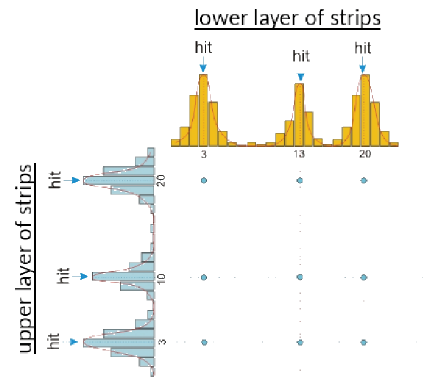
spatial coordinates represented by intersections of fired strips. Search for a cluster and its parameterization are done separately in each layer. Generally speaking, a layer with a given set of fired strips is considered as a one-dimensional discrete spectrum to be analyzed. In course of this analysis one has to reveal cluster structures of peak form in the spectrum. The found clusters are thus parametrized giving us a set of parameters which characterize each cluster. The most important among them are position of center of gravity of the cluster along strip axis, width of the cluster and its total charge. The positions of center found in two layers at the previous step describe average positions of fired strips to be intersected in order to get spatial coordinates of a hit (see Fig. 2).